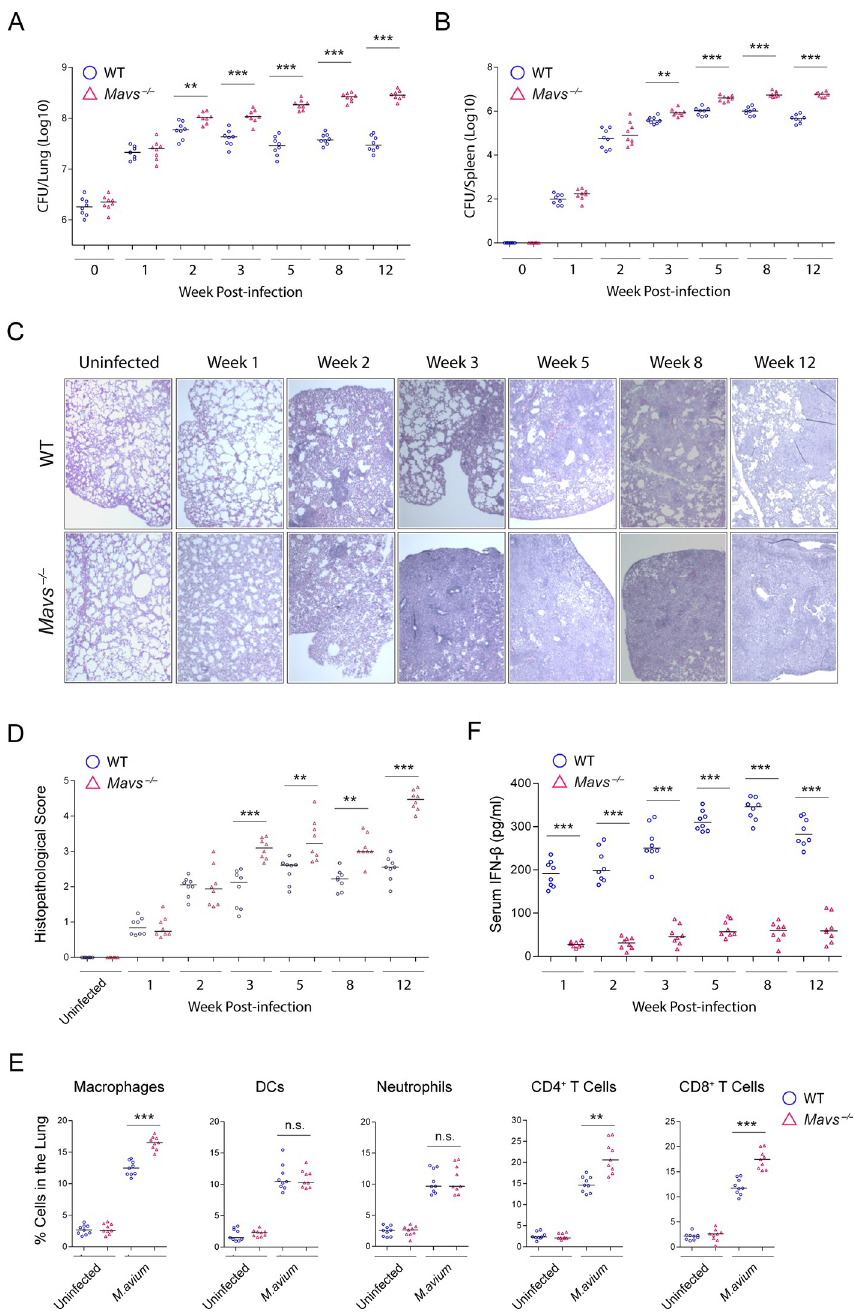
Fig 2. A MAVS-mediated RNA sensing pathway is required for M . avium control in mice. (A and B) M . avium 104 burden in the lung (A) and spleen (B) of WT and Mavs -/- mice at various time points post M . avium intratracheal infection at a dose of 1x10 7 CFU/mouse. (C) Representative H&E staining of lung sections from M . avium -infected WT and Mavs -/- mice at various time points post infection. (D) Histopathological scoring of H&E stained lung sections at various time points post M . avium infection. (E) Flow cytometry analysis for the composition of the different immune cells in WT and Mavs -/- mouse lungs at 3 weeks post M . avium infection. Shown as % of total cells counted. (F) ELISA analysis for IFN- β in serum of WT and Mavs -/- mice at various time points post M . avium infection. All data shown are the combination of two (A-D) or three (E and F) independent experiments. n.s., not statistically significant; �� P < 0.01 and ��� P < 0.001 by Mann–Whitney U